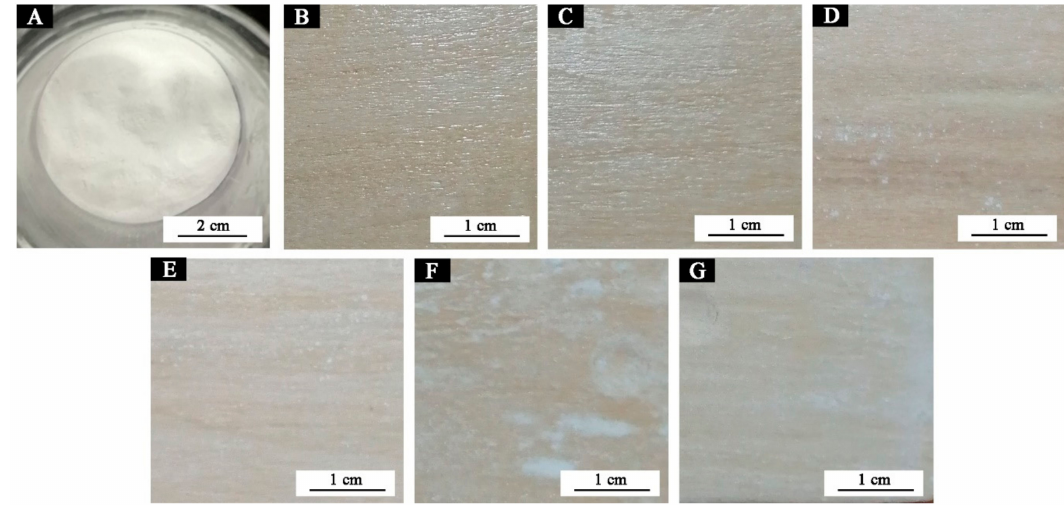
Figure 6. ( A ) Photographic images of microcapsules of 0.58:1 core–wall ratio and ( B – G ) the coatings with di ff erent concentrations of microcapsules of 0.58:1 core–wall ratio; ( B ) 0%; ( C ) 5.0%; ( D ) 10.0%;